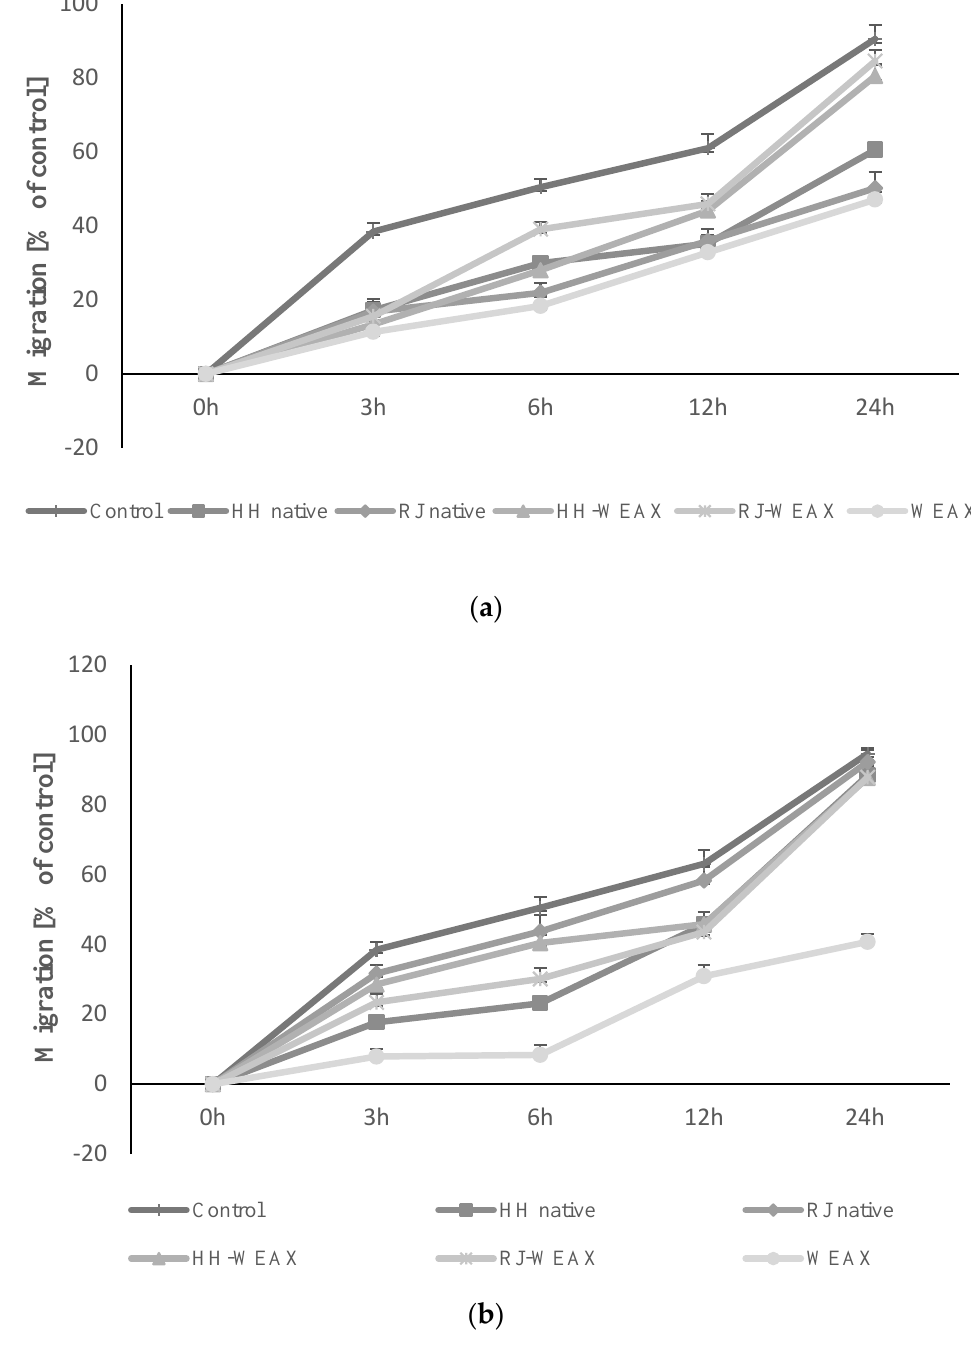
Figure 4. Assessment of cytotoxic activity of bee products encapsulated with WEAX biopolymer at 0.15 mg mL —1 concentration against NIH 3T3 ( a ) and HMEC-1 ( b ) cells. Each value on the graphs represents the mean value ± SEM, n = 3 .